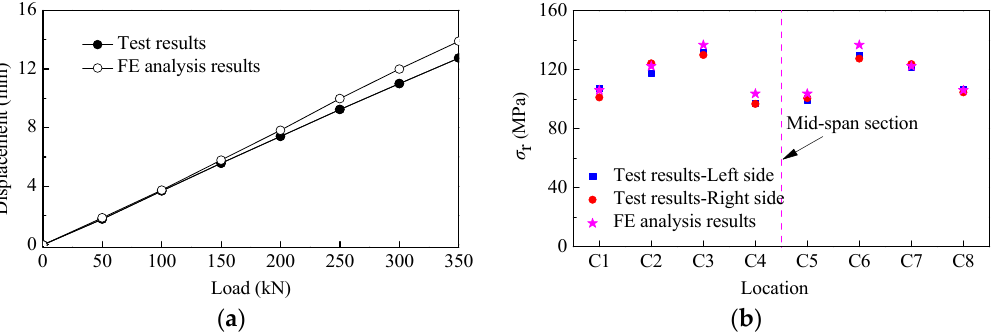
Figure 11. Comparison on test and FE analysis: ( a ) structural stiffness; and ( b ) hot spot stress.